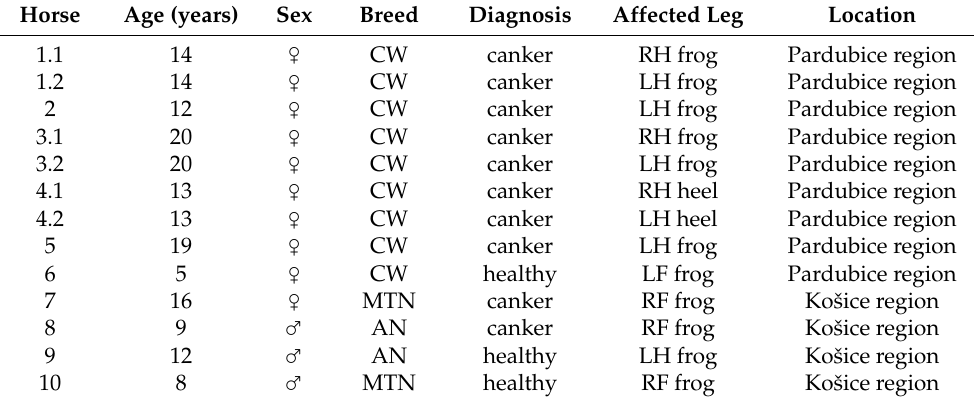
Table 2. Specification of equine hoof biopsies